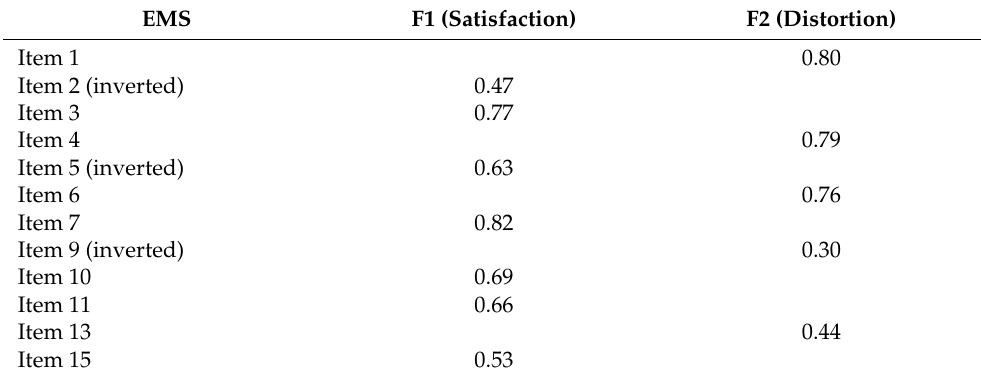
Table 3. Standardized factor loadings of the revised two-factor model of the EMS Scale.